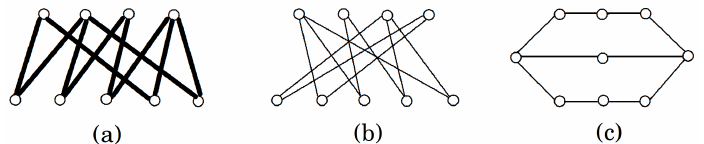
Figure 3: A red-blue coloring of K 4 , 5 in Example